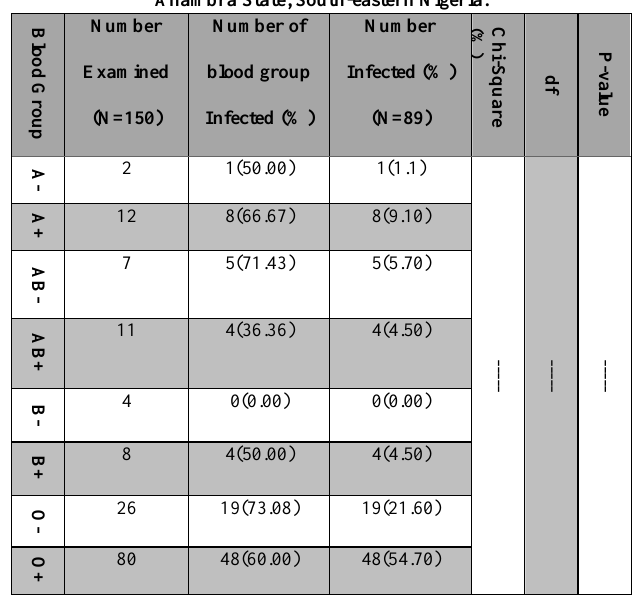
Table 4. Prevalence of malaria in conjunction with genotype among gravid women attending antenatal clinic at two Maternity Centres in Atani, Anambra State, South-eastern